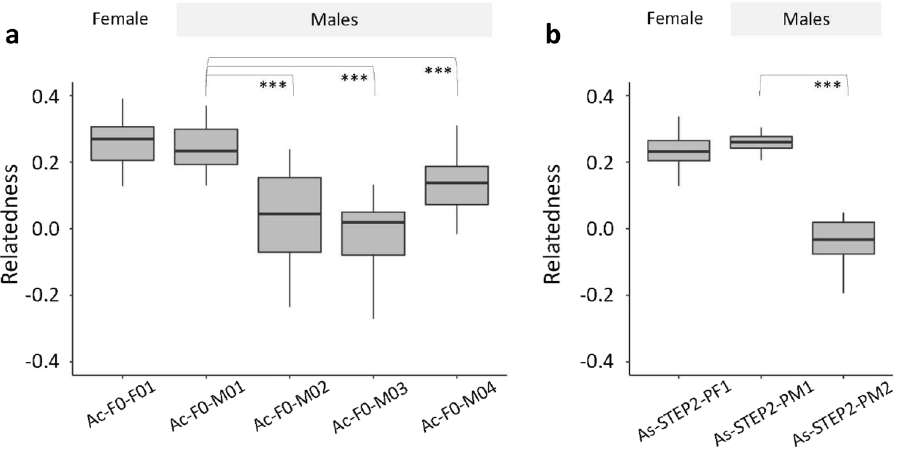
Figure 1. Male parent identification of A. coluzzii and A. stephensi offspring. Boxplots of relatedness values between each potential male parent and all offspring. Both species had a unique female parent and 4 potential